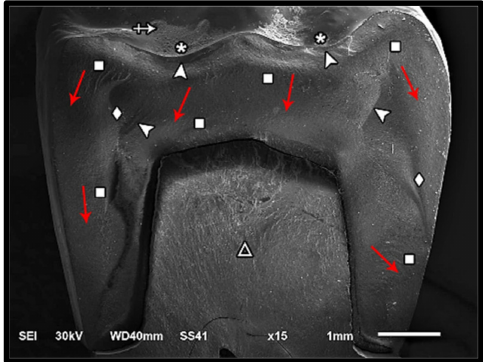
Figure 7. SEM micrograph for class III failure mode of zirconia fractured specimen showing fracture origins (asterisk) at the loading occlusal surface (two origins), hackle lines (square) indicating the direction of crack propagation from occlusal to cervical (red arrow), compression curl (diamond), diffused Arrest lines (arrow-head), loss of glazing layer at the position of loading piston (cross-arrow), and fracture of the restoration/tooth complex